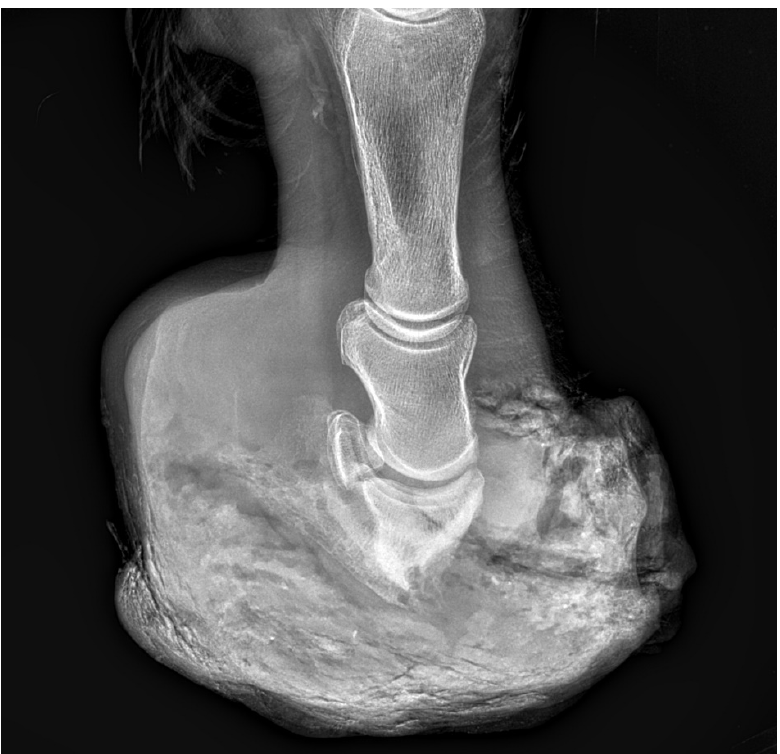
Figure 12. LM projection of the hoof from postmortem examination, revealing a visible large mass in the dorsal part of the hoof capsule pressing against the hoof bone and leading to its lysis.